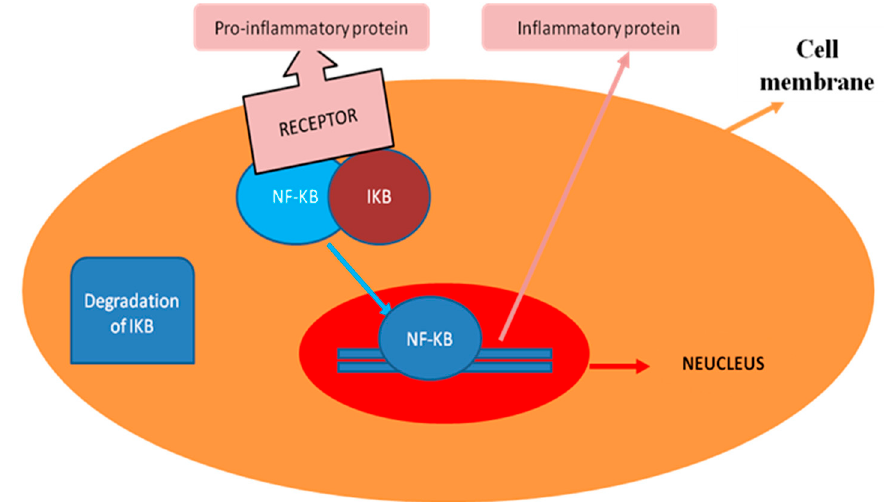
Figure 3. The regulation of the inflammation process by pro-inflammatory cytokines through NF- κ B signaling; the cytokines, after attachment with receptors, cause the degradation of IKB from NF- κ B. Upon activation, NF- κ B directly binds to the promoters of target genes on DNA in the nucleus and regulates the specific inflammatory proteins.